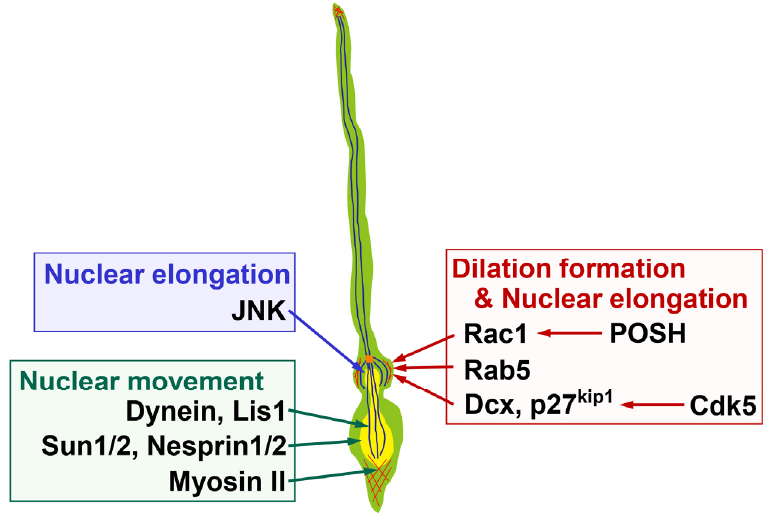
Figure 3. Molecules regulating the dilation formation and nuclear deformation in locomoting neurons. POSH-mediated regulation of Rac1 localization and its downstream actin reorganization, Rab5-mediated endocytic pathways and Cdk5-Dcx/p27 kip1 pathways, regulate dilation formation. JNK, as well as POSH-Rac1, Rab5, Cdk5-Dcx/p27 kip1 are required for nuclear elongation. Dynein/Lis1, Sun1/2, Nesprin1/2 and Myosin II control nuclear movement. Yellow and orange circles indicate the nucleus and centrosome, respectively. Blue and red lines indicate microtubules and F-actin, respectively. See the text for more details.